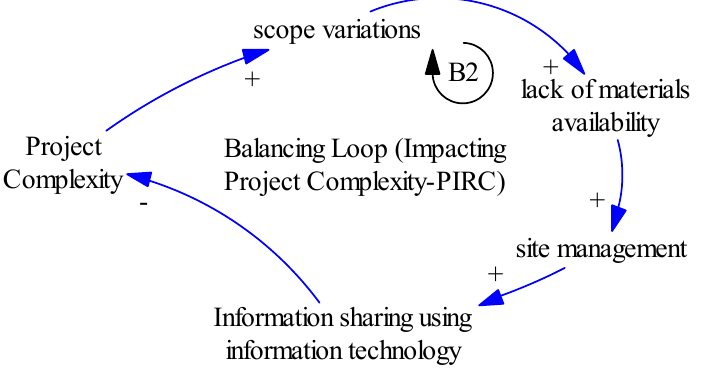
Figure 8. Impact on profitability risk category–complexity (balancing loop-B2).